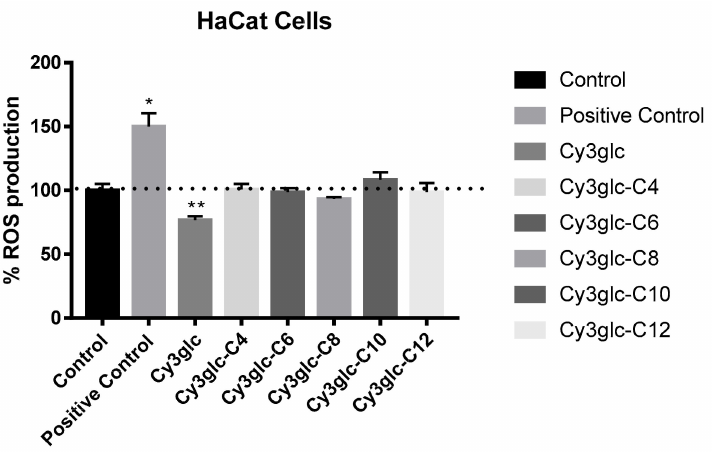
Figure 4. Effect of Cy3glc and Cy3glc-fatty acid derivatives at 50 µ M, on ROS production after 24 h in HaCat cells. Hydrogen peroxide was used as a positive control. Statistical comparisons were performed in comparison to control. * p < 0.05, p **<